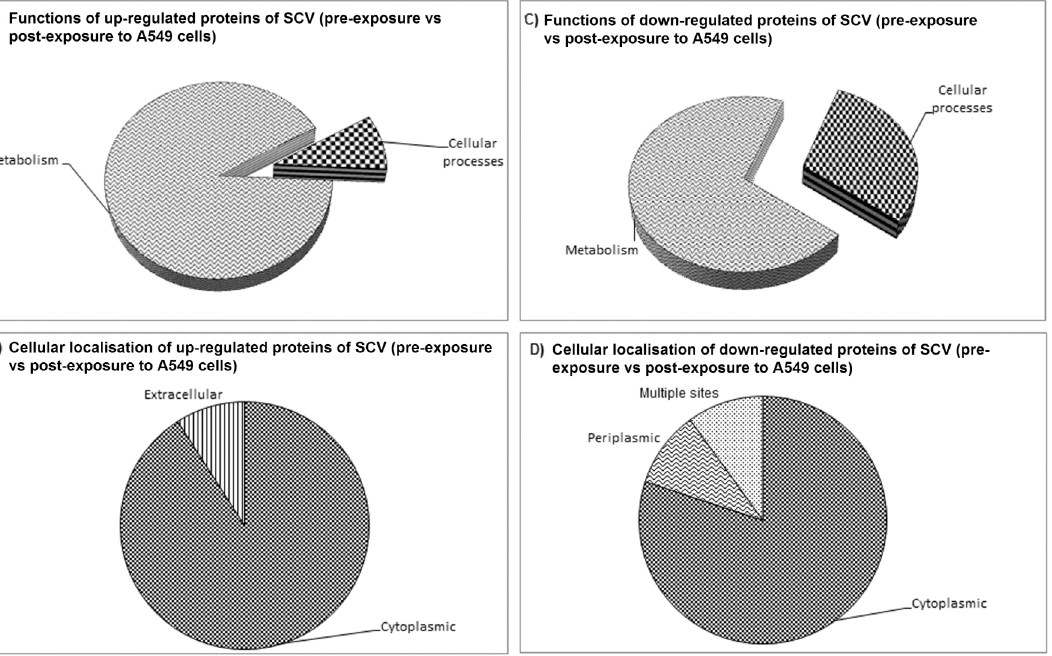
Fig 7. Protein categories and the subcellular localisation of Burkholderia pseudomallei WT (pre-exposure vs post-exposure to A549 cells). Functional protein categories were predicted using COG, while subcellular localisation was predicted using PSORT. Panels A and B refer to functions and cellular location of the up-regulated proteins, respectively. Panels C and D refer to functions and cellular location of the down-regulated proteins,